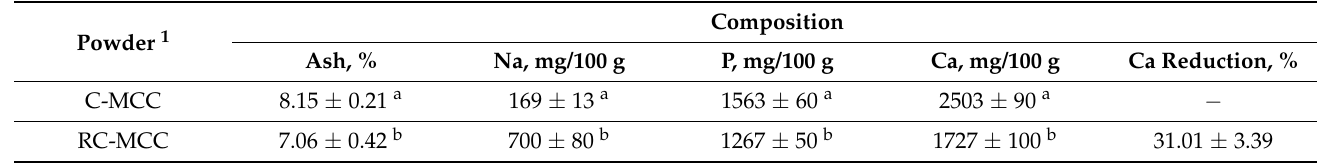
Table 2. Mean (n = 3) mineral composition of the micellar casein concentrate.